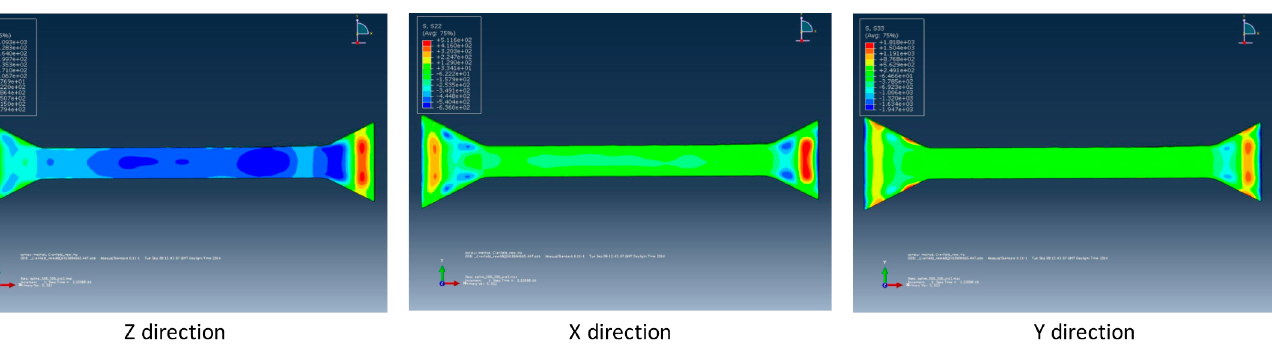
Figure 5. Residual stress maps from the test peg based on the contour method.